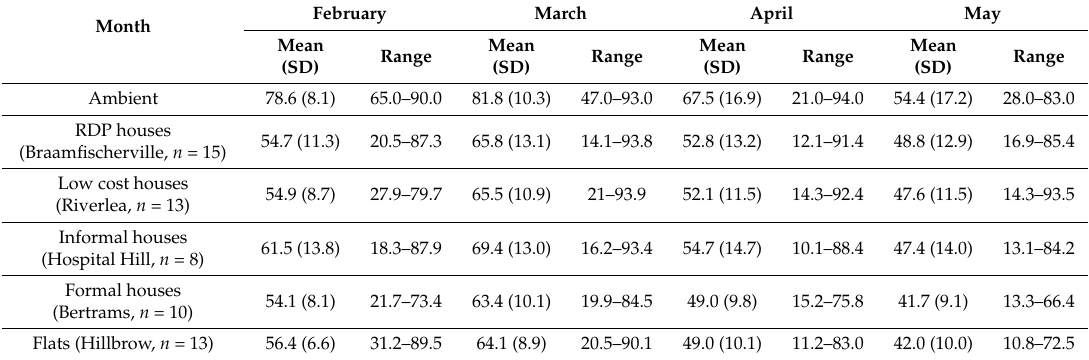
Table 4. Mean (standard deviation) and range in monthly indoor and ambient relative humidity (%)